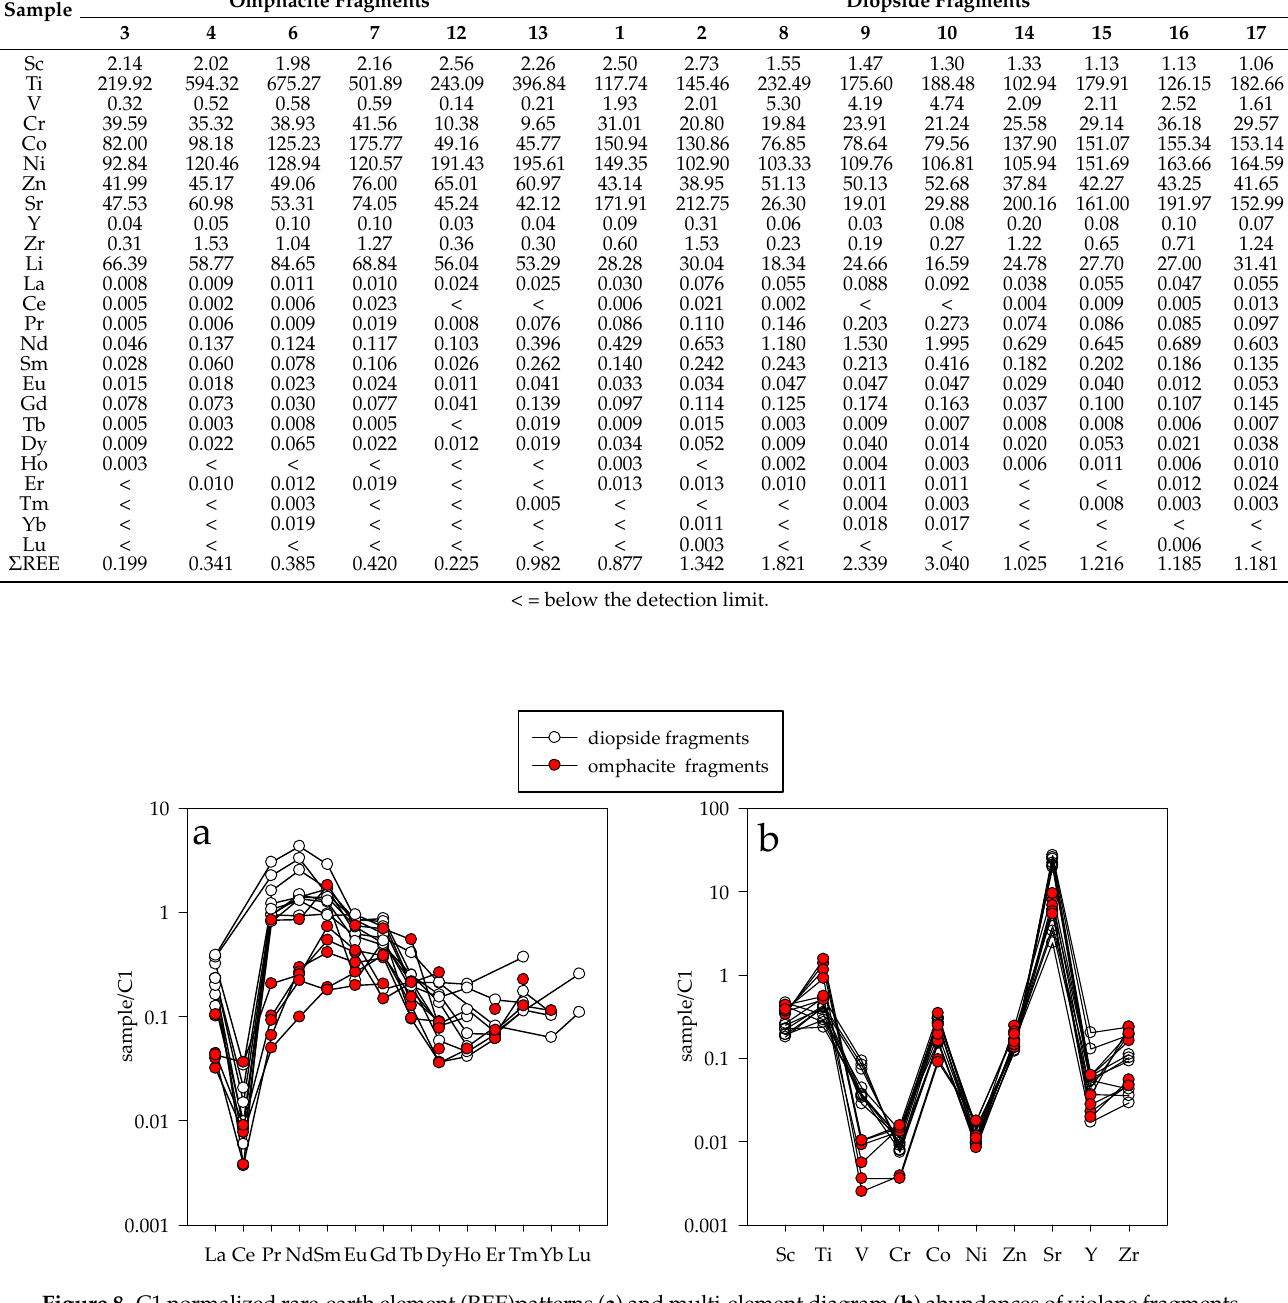
Figure 8. C1 normalized rare-earth element (REE)patterns ( a ) and multi-element diagram ( b ) abundances of violane frag- ments.